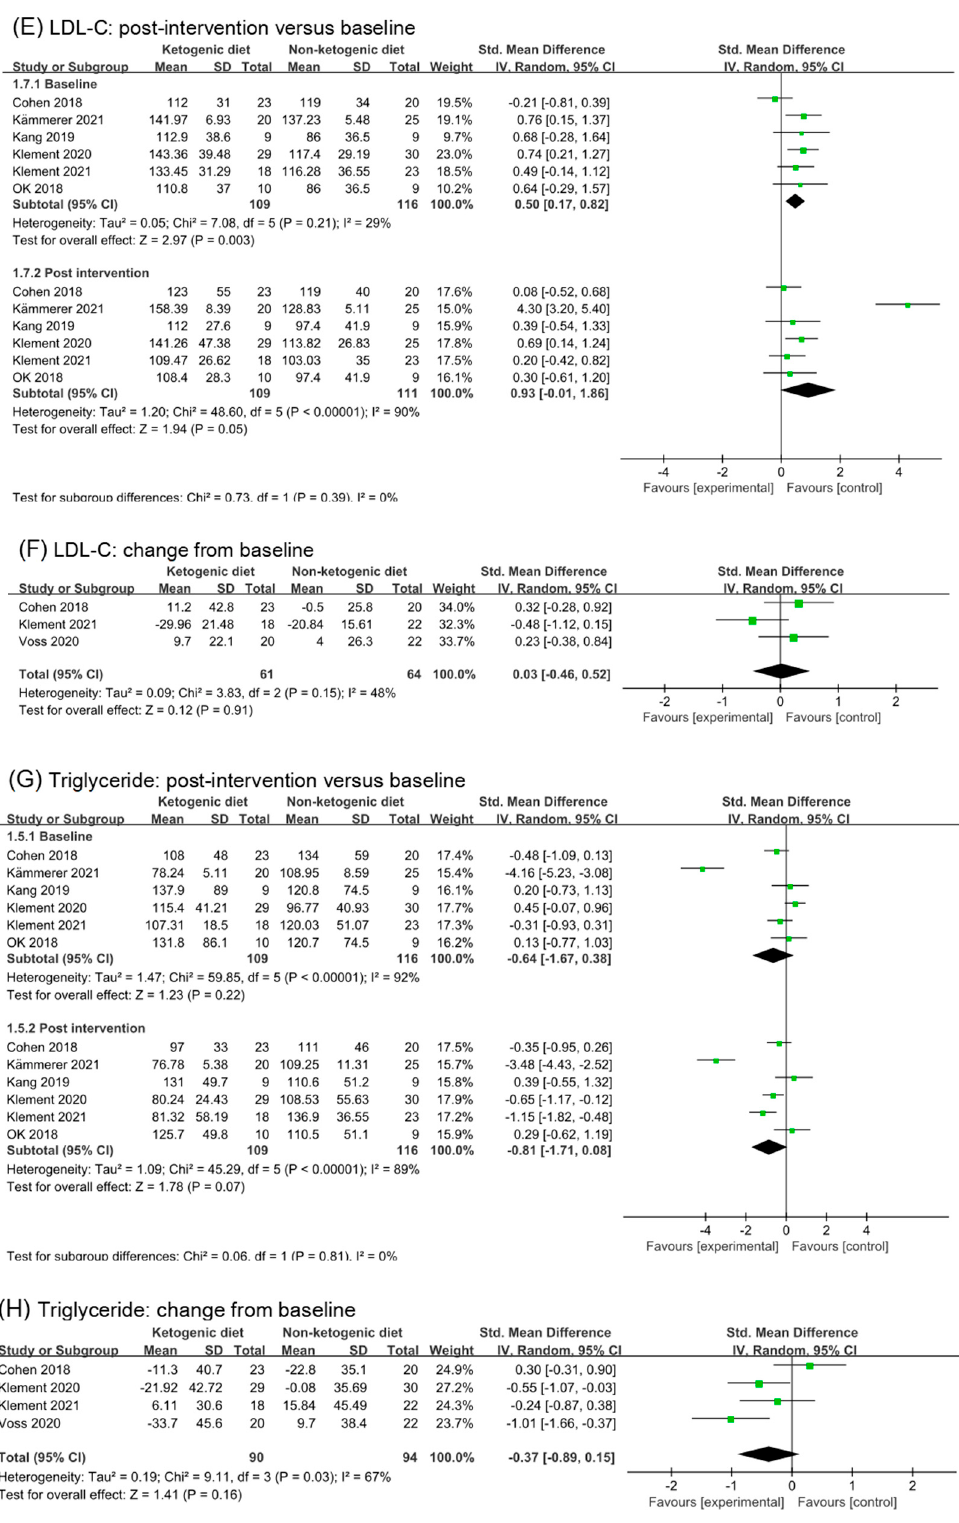
Figure 5. Forest plot for the effects of ketogenic diets on lipid profiles. ( A , B ) were subgroup effects of the baseline versus post-intervention and effect of change from baseline on total cholesterol; ( C , D ) were ones on HDL-C; ( E , F ) were ones on LDL-C; ( G , H ) were ones on triglycerides [26–33,35–42].